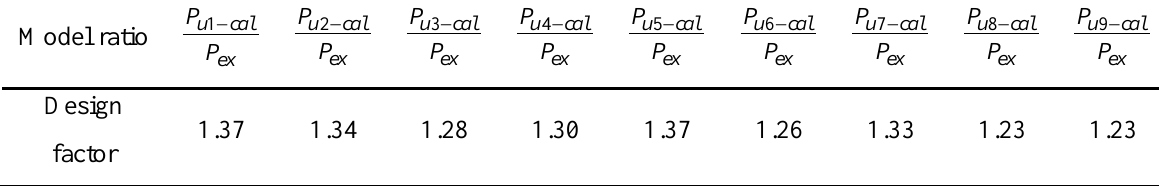
 for the calibrated d